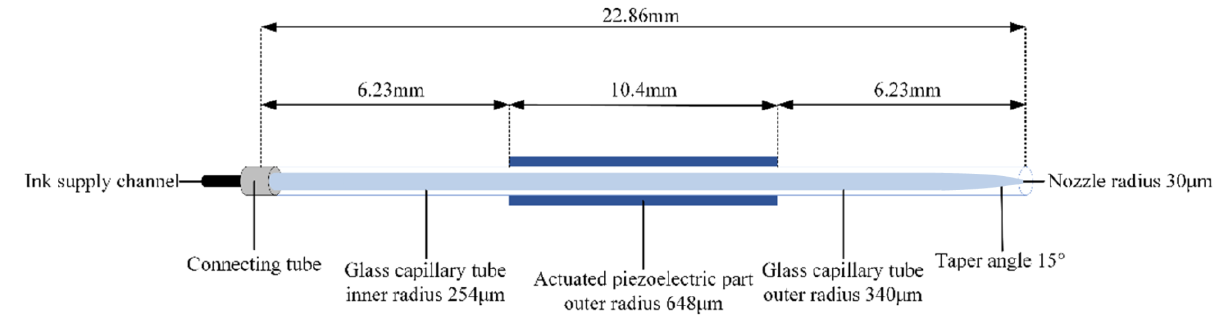
Figure 1. Schematic of squeeze-type piezoelectric inkjet printhead.